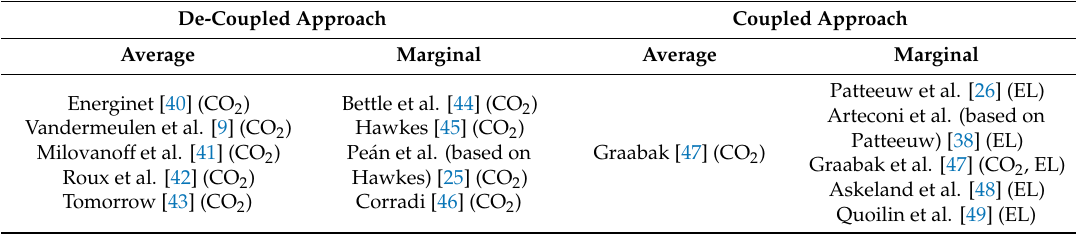
Table 1. Categorization of methodologies to evaluate CO 2eq. intensities of the electricity mix (marked as ‘CO 2 ’) or determine the optimal dispatch and unit commitment in electricity grids (marked as